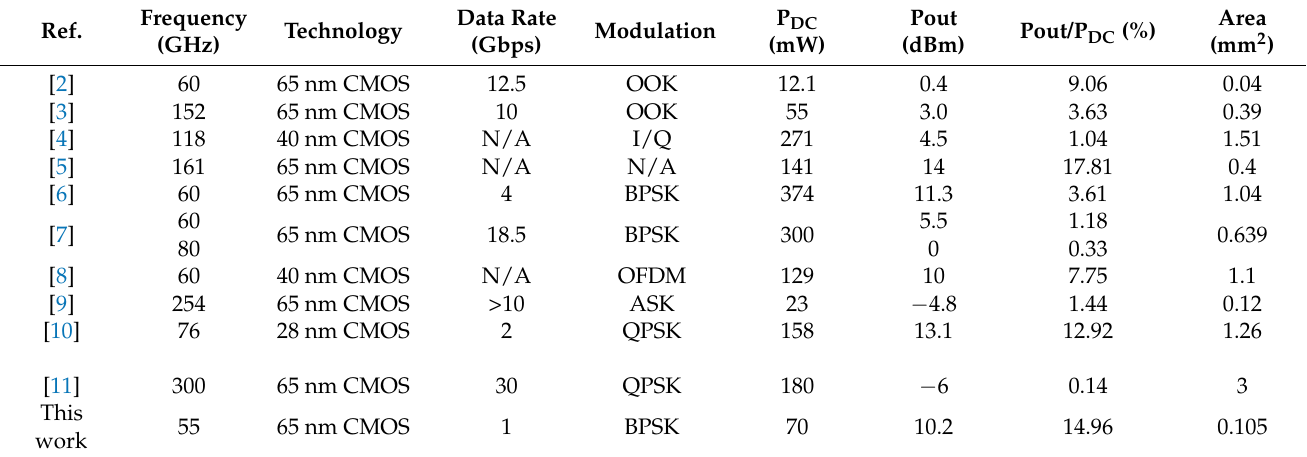
Table 2. Comparison of the CMOS millimeter-wave